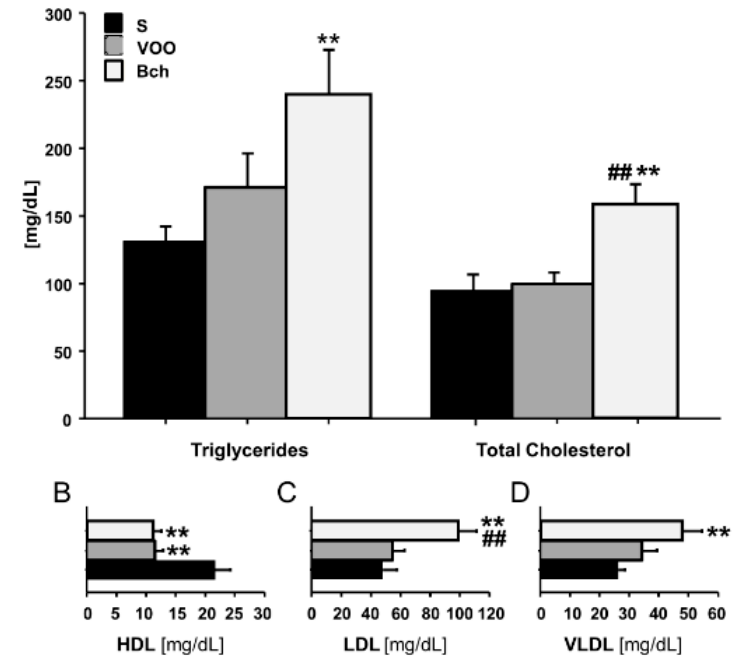
Figure 2. Values represent mean ± SEM levels, expressed in mg/dL, of plasma total triglycerides and cholesterol ( A ), and HDL ( B ), LDL ( C ) and VLDL ( D ) cholesterol fractions in standard (S), virgin olive oil (VOO) and butter plus cholesterol (Bch) diets. ** ( p < 0.01) differences vs. standard diet, ## ( p < 0.01) differences vs. virgin olive oil diet.